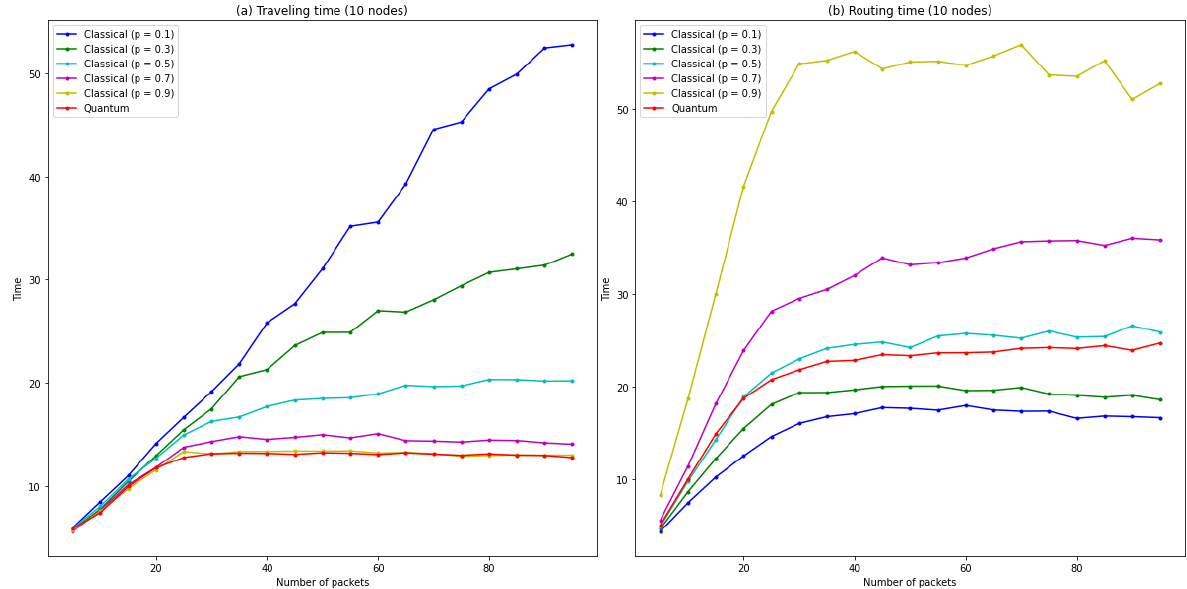
Figure 6. Graphs for different probabilities p and the quantum case: ( a ) Traveling time as a function of the number of packets. ( b ) Routing time as a function of the number of packets.